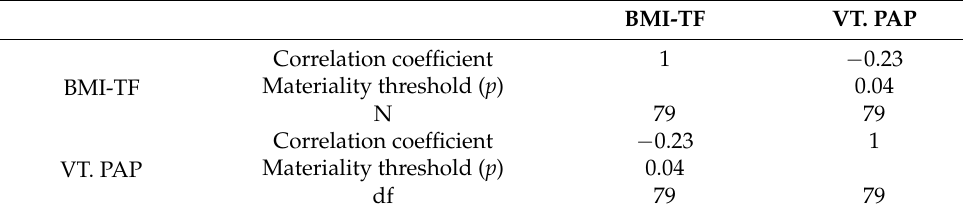
Figure 9. Scatter diagram for the relationship between the body mass index determined at the final testing and the total amount of time devoted to physical activity (hours). testing and the total amount of time devoted to physical activity (hours). Table 11. Results of the Pearson correlation analysis between the body mass index determined at final testing and the total amount of time devoted to the physical activity programme